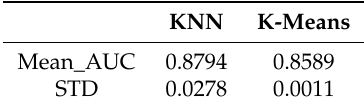
Table 2. Comparison of the effects of KNN and K-means on